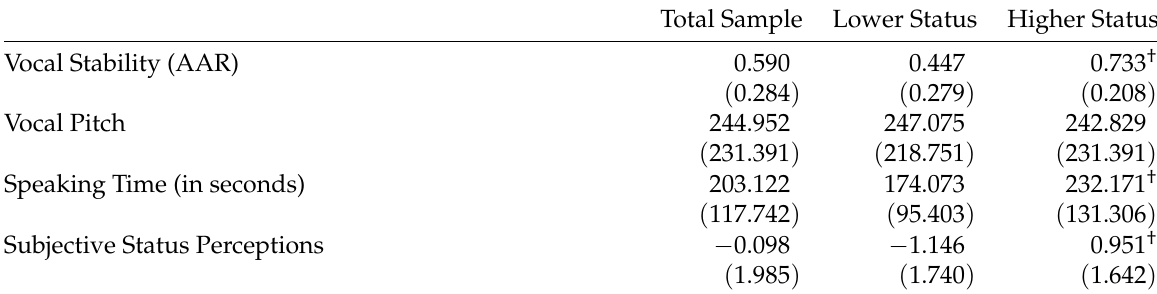
Table 3: Descriptive statistics ( N =